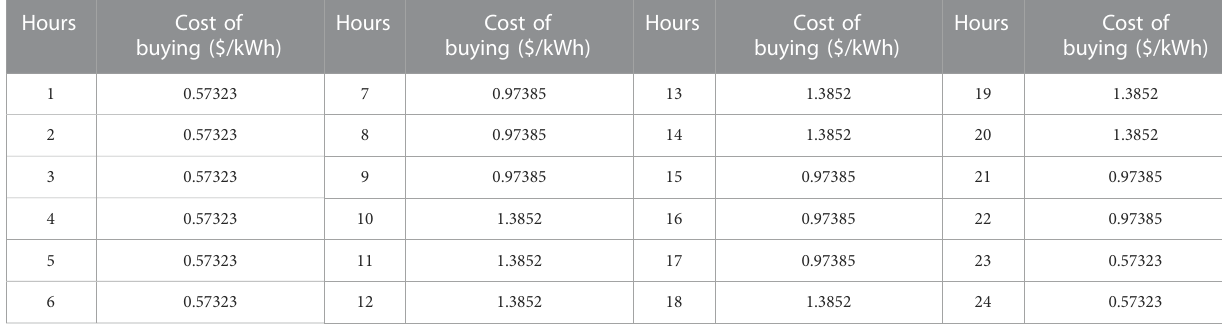
TABLE 4 Cost of buying power for the industrial microgrid from the main grid (Yona et al.,